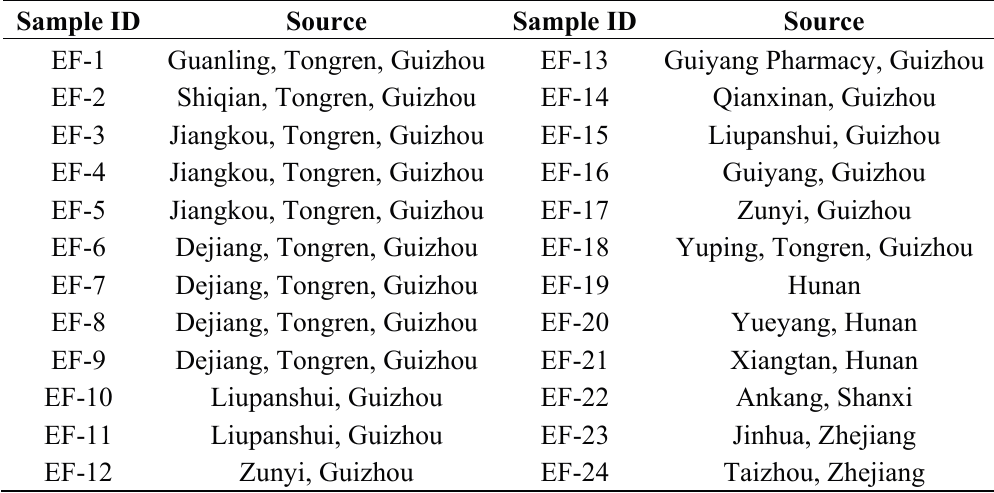
Figure 1. PCA scores plot of the tested EF samples obtained in positive ion mode. Each mark represents an analysis of a sample, and the labels represent corresponding samples listed in Table 1. Table 1. Source information of EF samples tested in the present